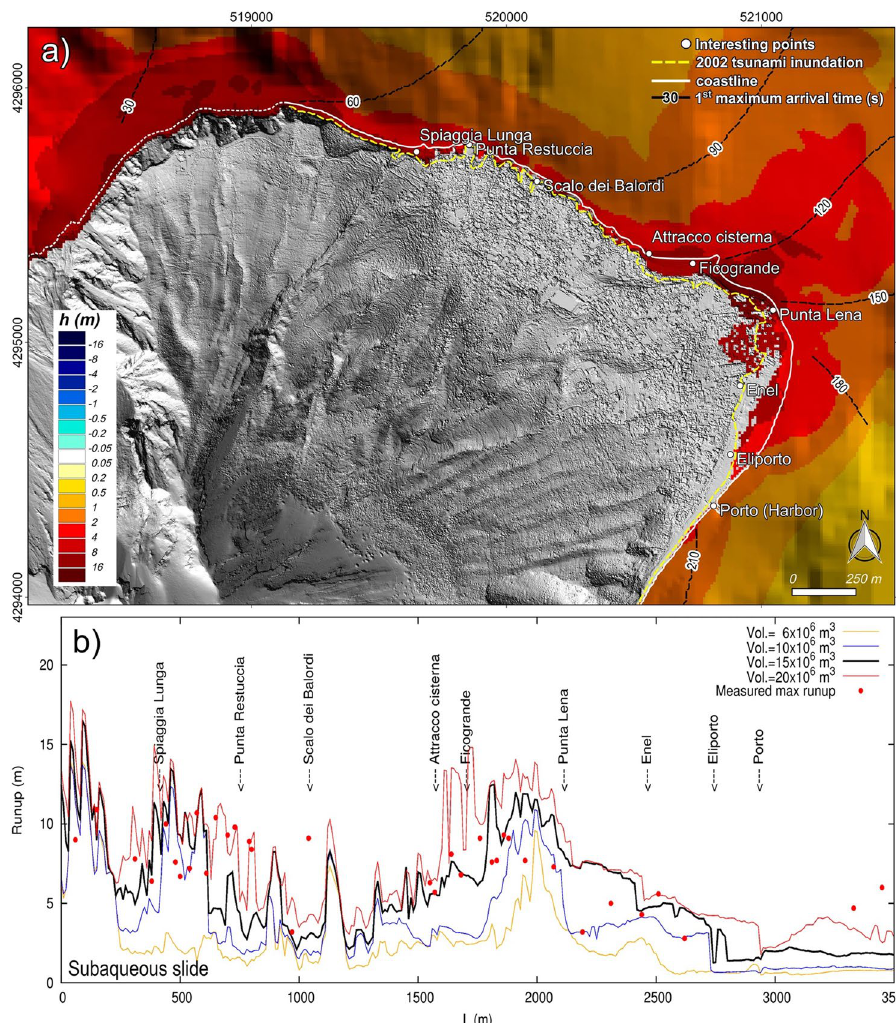
Figure 4. Observed and simulated tsunami effects comparison at Stromboli. ( a ) Stromboli map representing the maximum simulated inundation and wave height for a tsunami caused by a submarine slide along the SdF of 15 × 10 6 m 3 . Map was generated using Quantum GIS 2.8.1 software (https:// www. qgis. org). ( b ) Comparison between the 2002 runups observed by Tinti et al. 7 and runups simulated in case of submarine